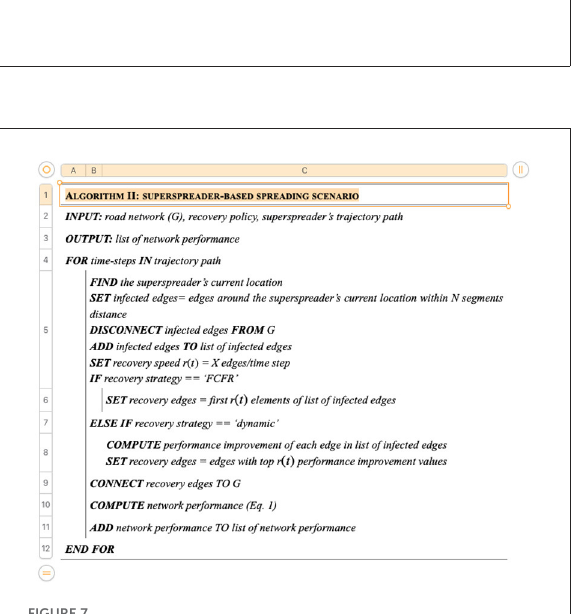
FIGURE6 Algorithm I: Sporadic spreading scenario.